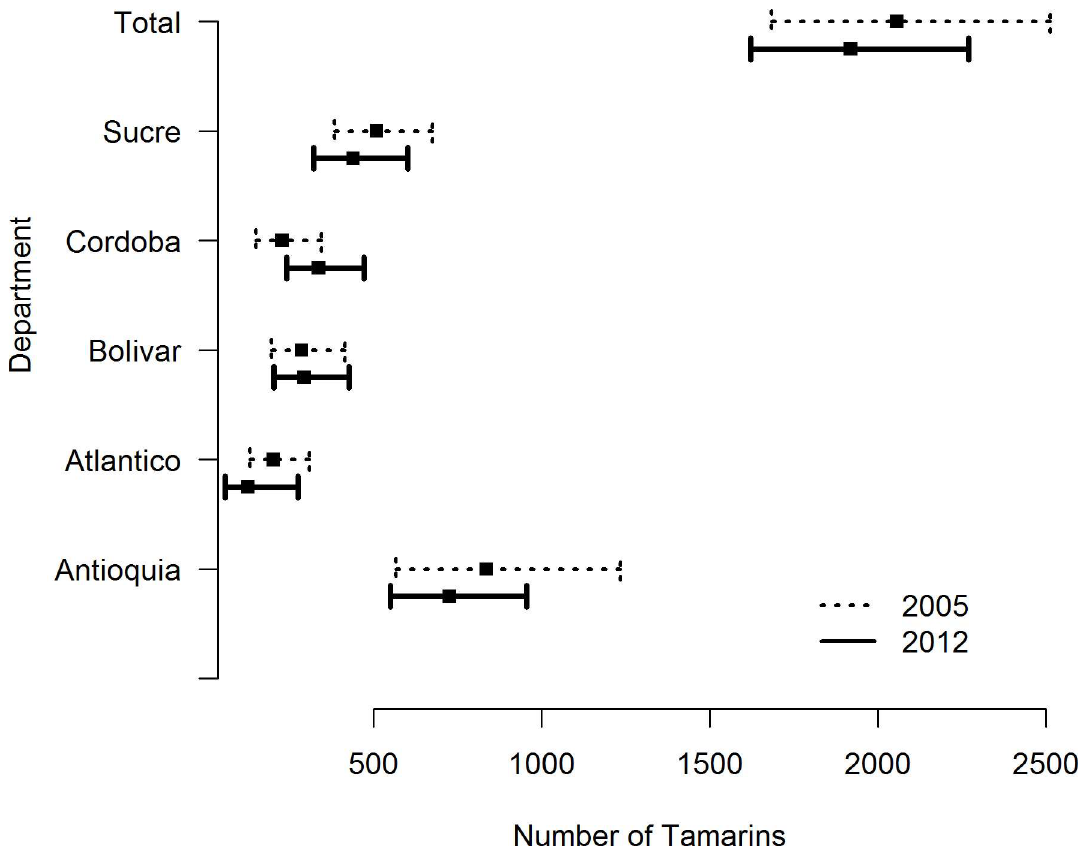
Fig 1. Estimated population size (with 95% confidence interval) of cotton-top tamarins in surveyedareasin Colombia (overall and separated by department) and in each department in 2005 and